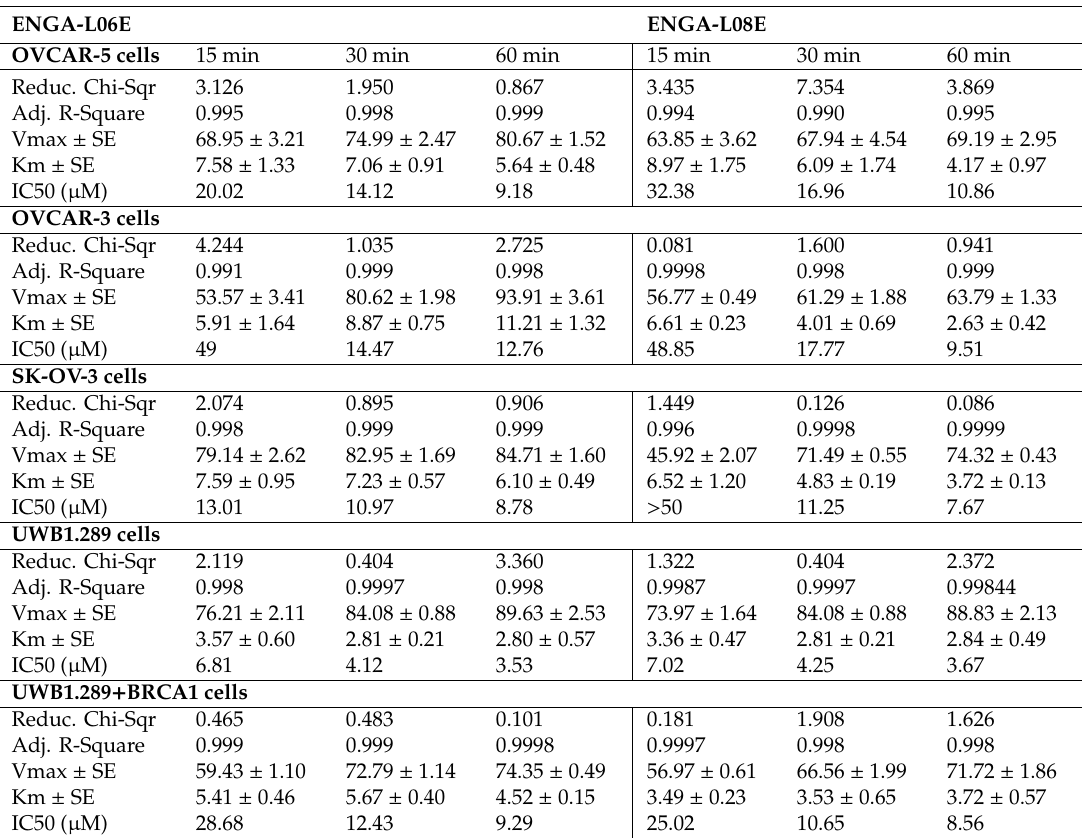
Table A1. The results of inhibitory e ff ects of ENGA-L06E and ENGA-L08E on ERK1,2 phosphorylation, in all studied cancer cell lines, as well as the corresponding kinetics according to Michaelis Menten model (significance level p <